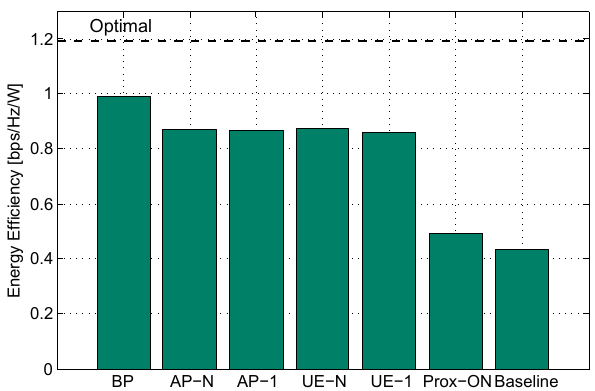
Figure 4. Comparison of the average energy efficiency among BP, DANCE and the baseline.